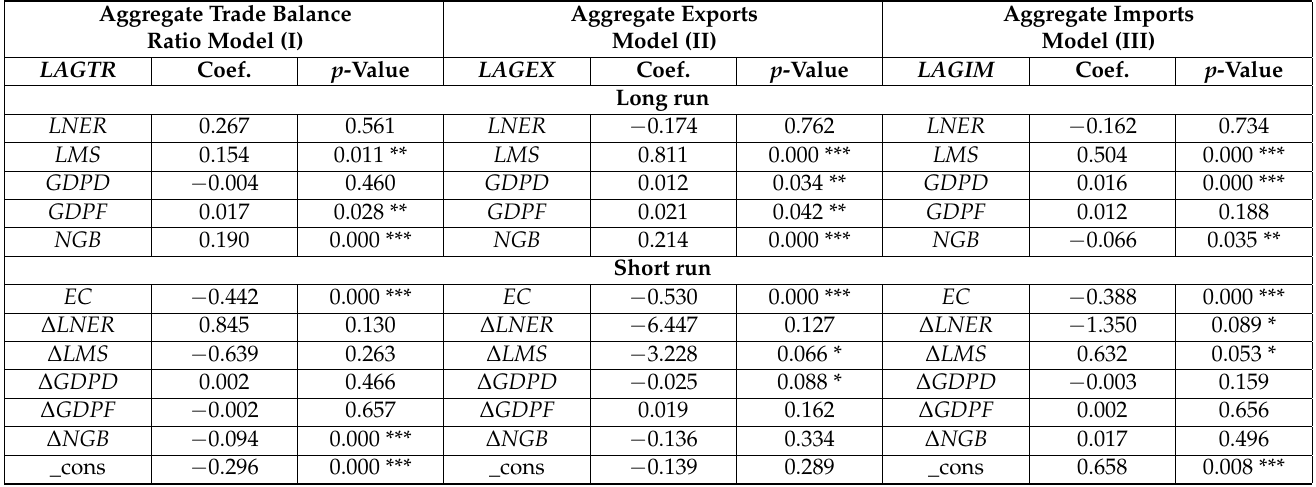
Table 2. The determinants of T&T’s aggregate trade 1991–2019 using PMG